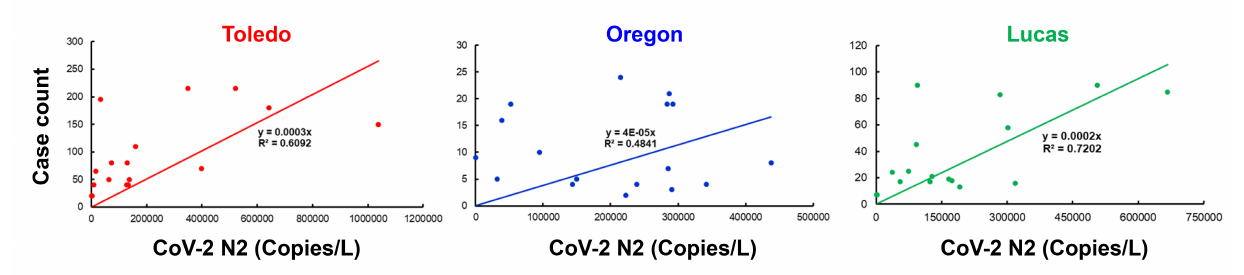
Figure 5. The correlative analyses of the SARS-CoV-2 gene copies with the COVID-19 case counts. The gene copies (per L) were plotted against the case numbers and correlative analyses were performed.